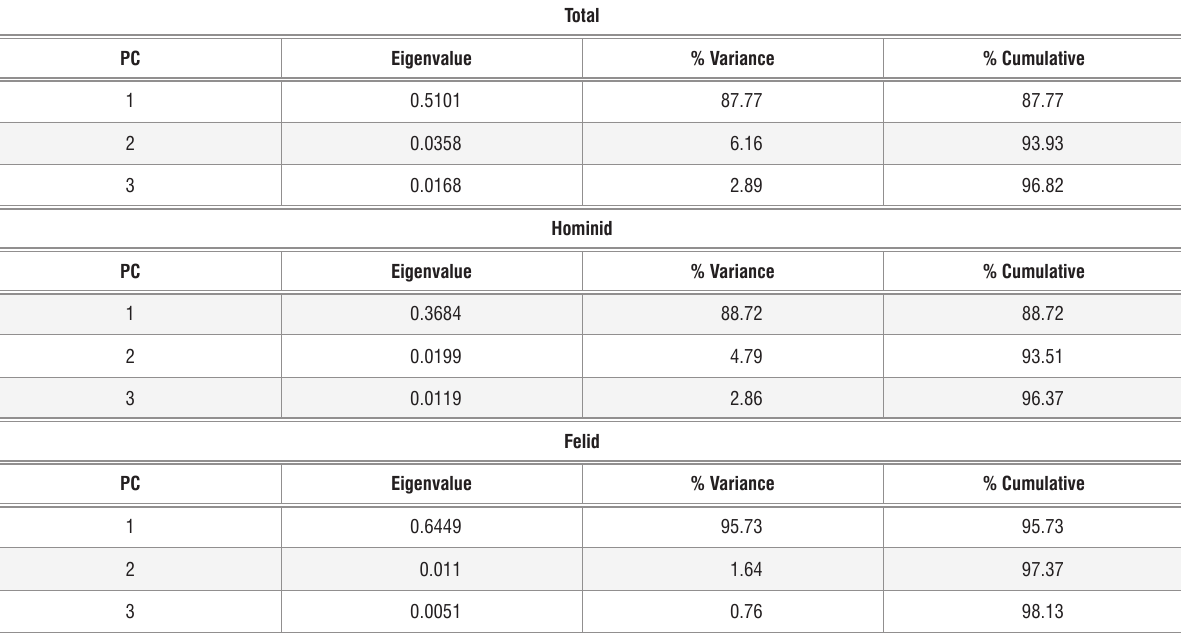
Summary statistics for the principal components (PC) analysis: raw data